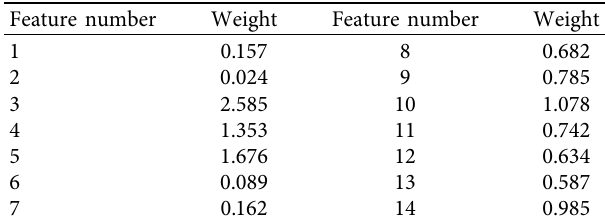
Table 1: Weight of each feature.